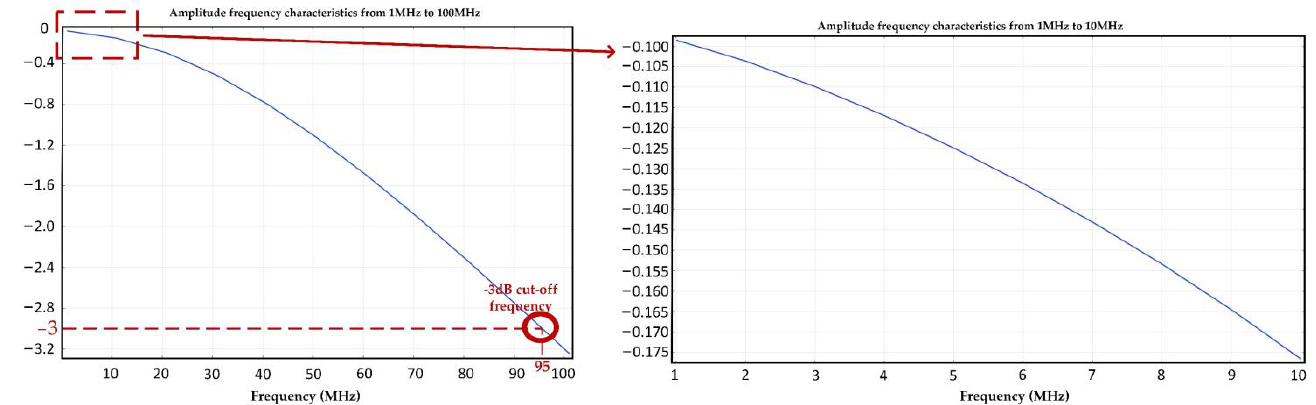
Figure 7. The response characteristics of signal conditioning circuit in the range of 1 MHz to 100 MHz simulated by COMSOL Multiphysics software.